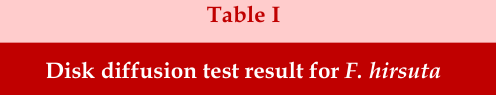
Disk diffusion test result for F.